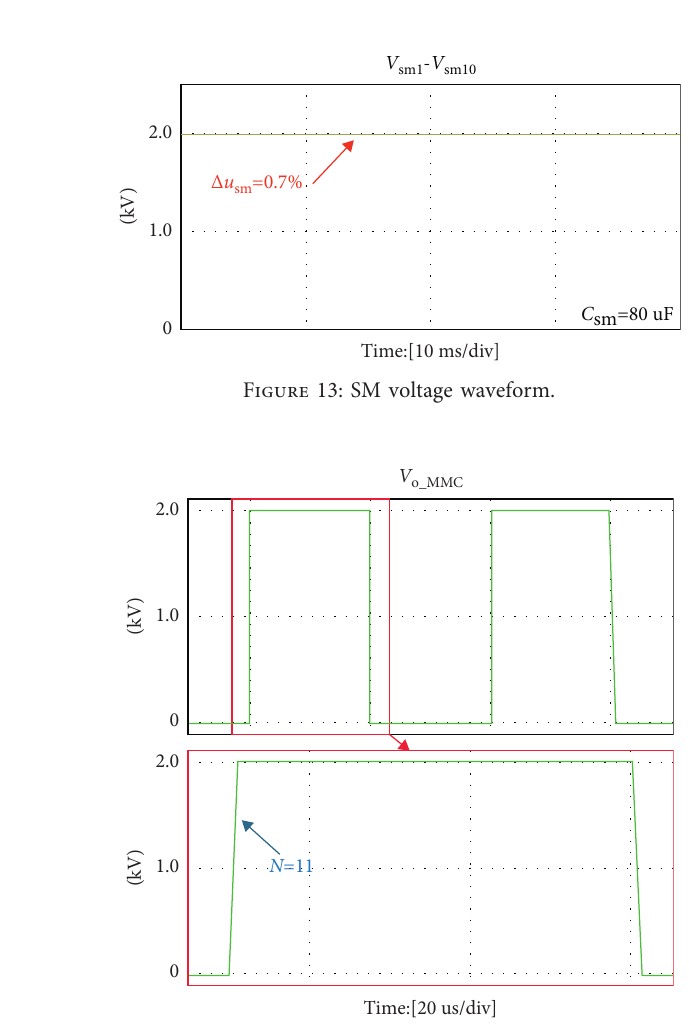
Figure 14: MMC side modulation